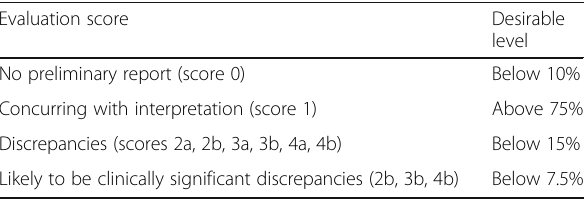
Table 7 Proposed standard levels of evaluation score for residency programs Evaluation